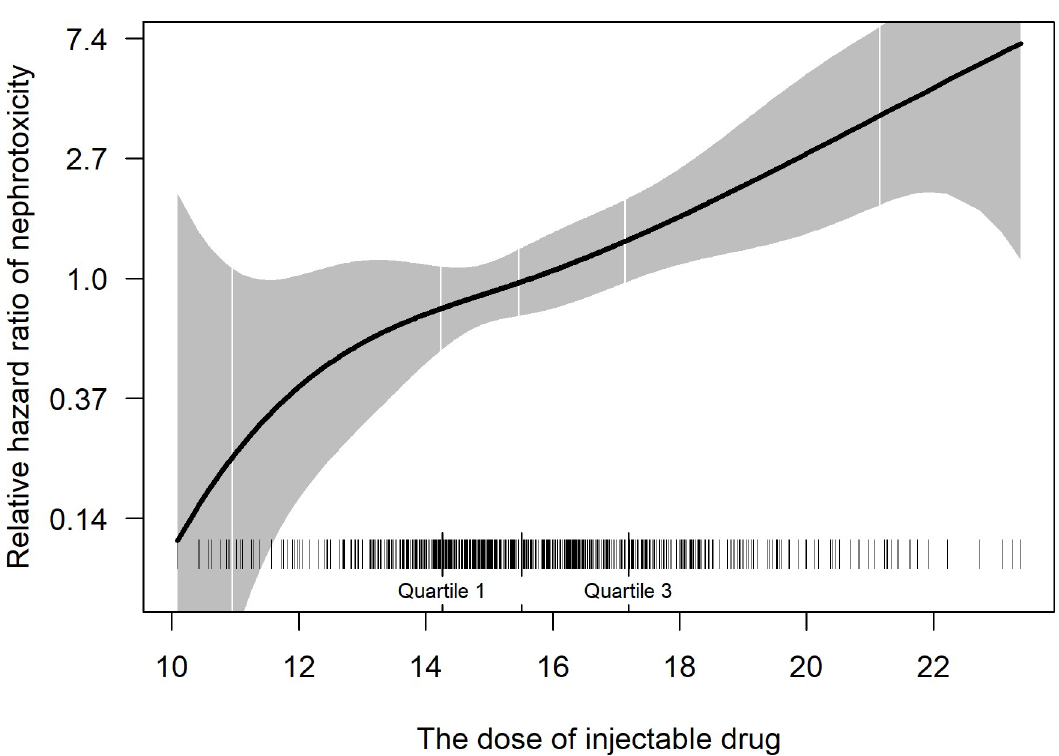
Fig 1. The relationship between the average daily dose of injectable drugs and nephrotoxicity. Relative hazard ratio (solid line) and 95% confidence intervals (shading) are estimated from the Cox model with injectable drug dose as a spline function. The model was adjusted for age, gender, body mass index, alcohol dependence, diabetes, and pre-existing renal disease. Patient distributions by dose are noted as small vertical ticks.